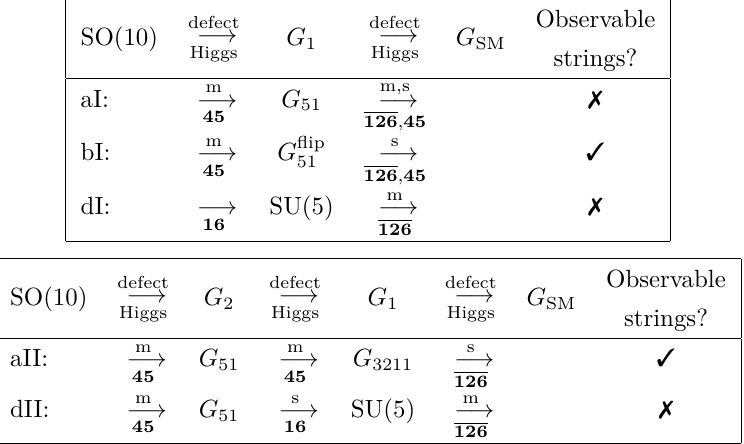
Table 1 . Type (a), (b), (d) breaking chains with one (I) and two (II) intermediate gauge symme- tries. The representation of the Higgs multiplet responsible for the spontaneous symmetry breaking is listed under the arrow. Topological defects, including monopoles (m), strings (s) and domain walls (w), induced by such breaking, are listed above arrows. A blank above an arrow implies that no defects are formed. An explanation of observable strings are given in the main